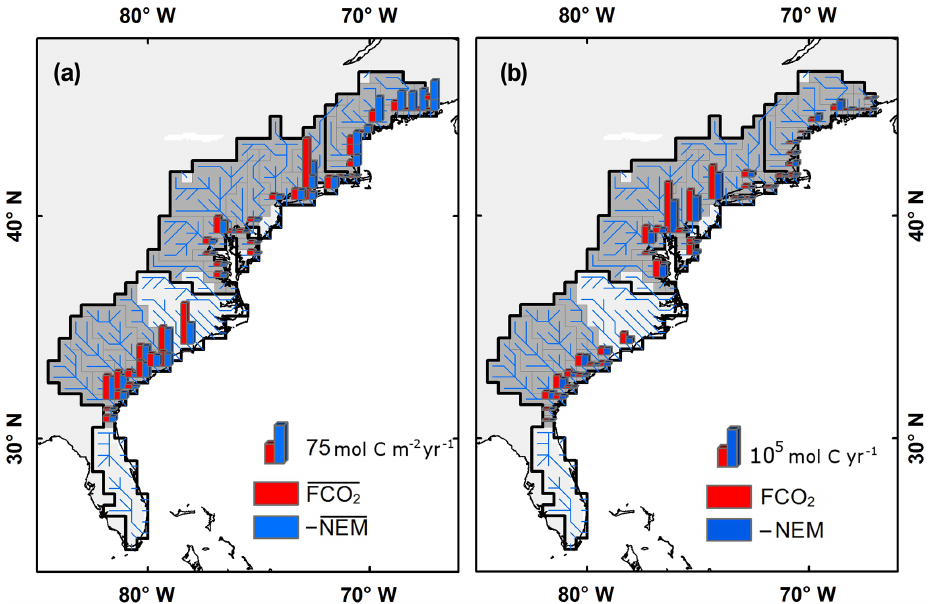
Figure 8. Spatial distribution of spatially averaged value (a) and integrated value (b) of mean annual FCO 2 (red) and − NEM (blue) along the US East Coast. In panel (a), the notation with over bars (FCO 2 and − NEM ) represents rates per unit surface. For the sake of the comparison with FCO 2 , Fig. 8 displays − NEM because the model predicts that all estuaries in this region are net